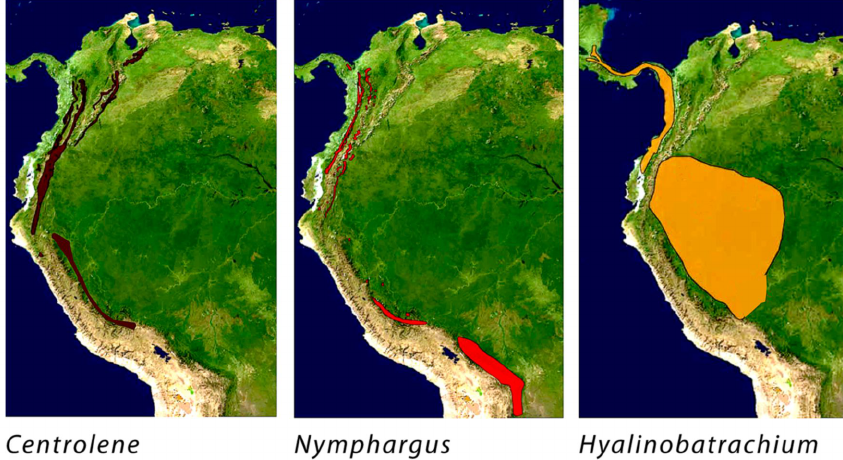
Figure 235. Niche conservatism in glassfrogs at the generic level (modified from Guayasamin et al. [1]). Note that distribution of genera is restricted to particular biogeographic regions, suggesting that closely related species have similar climatic requirements. Number of species per genera are as follows: Centrolene = 24, Nymphargus = 41, Hyalinobatrachium =